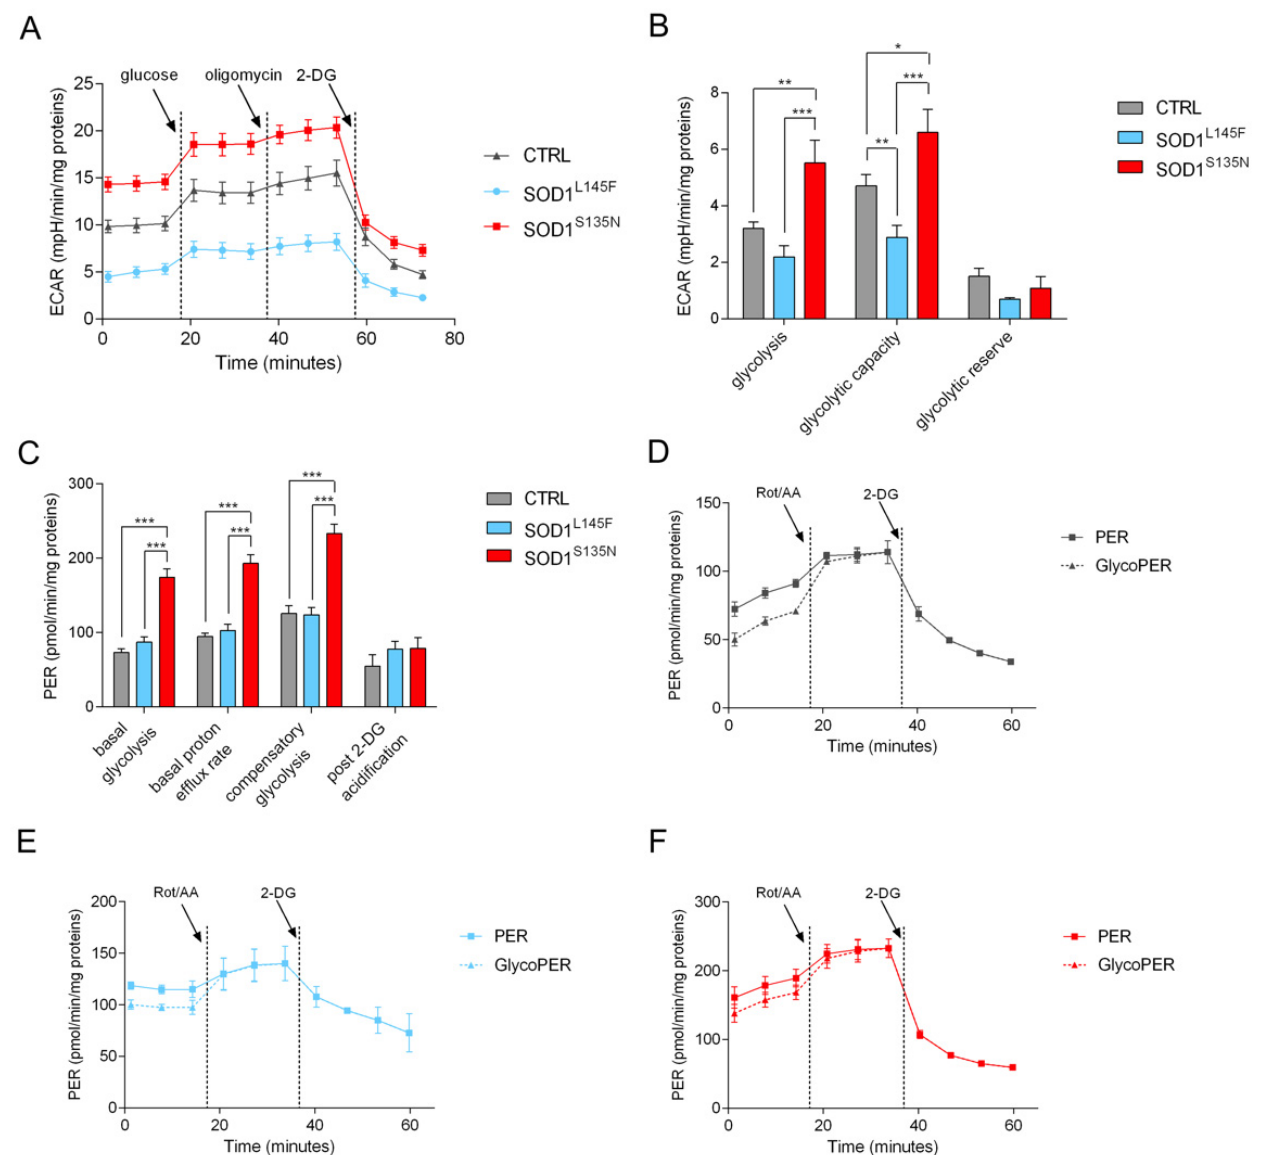
Figure 8. Glycolysis evaluation. ( A ) Representative ECAR profiles of control and SOD1 mutant cells of at least three independent experiments, expressed as mpH/min/mg proteins. The arrows indicate the time of addition of glucose, oligomycin and 2-DG. ( B ) Analysis of different glycolytic parameters. ( C ) Analysis of basal and compensatory glycolytic levels in control and SOD1 mutant cells. Representative PER and glycoPER profiles of control cells ( D ), SOD1 L145F ( E ), and SOD1 S135N ( F ) mutant cells expressed as pmol/min/mg protein. The arrows indicate the time of rotenone/antimycin A and 2-DG addition. Results are expressed as the mean ± SEM of at least three independent experiments. Statistical significance: * p < 0.05, ** p < 0.01, *** p < 0.0013.